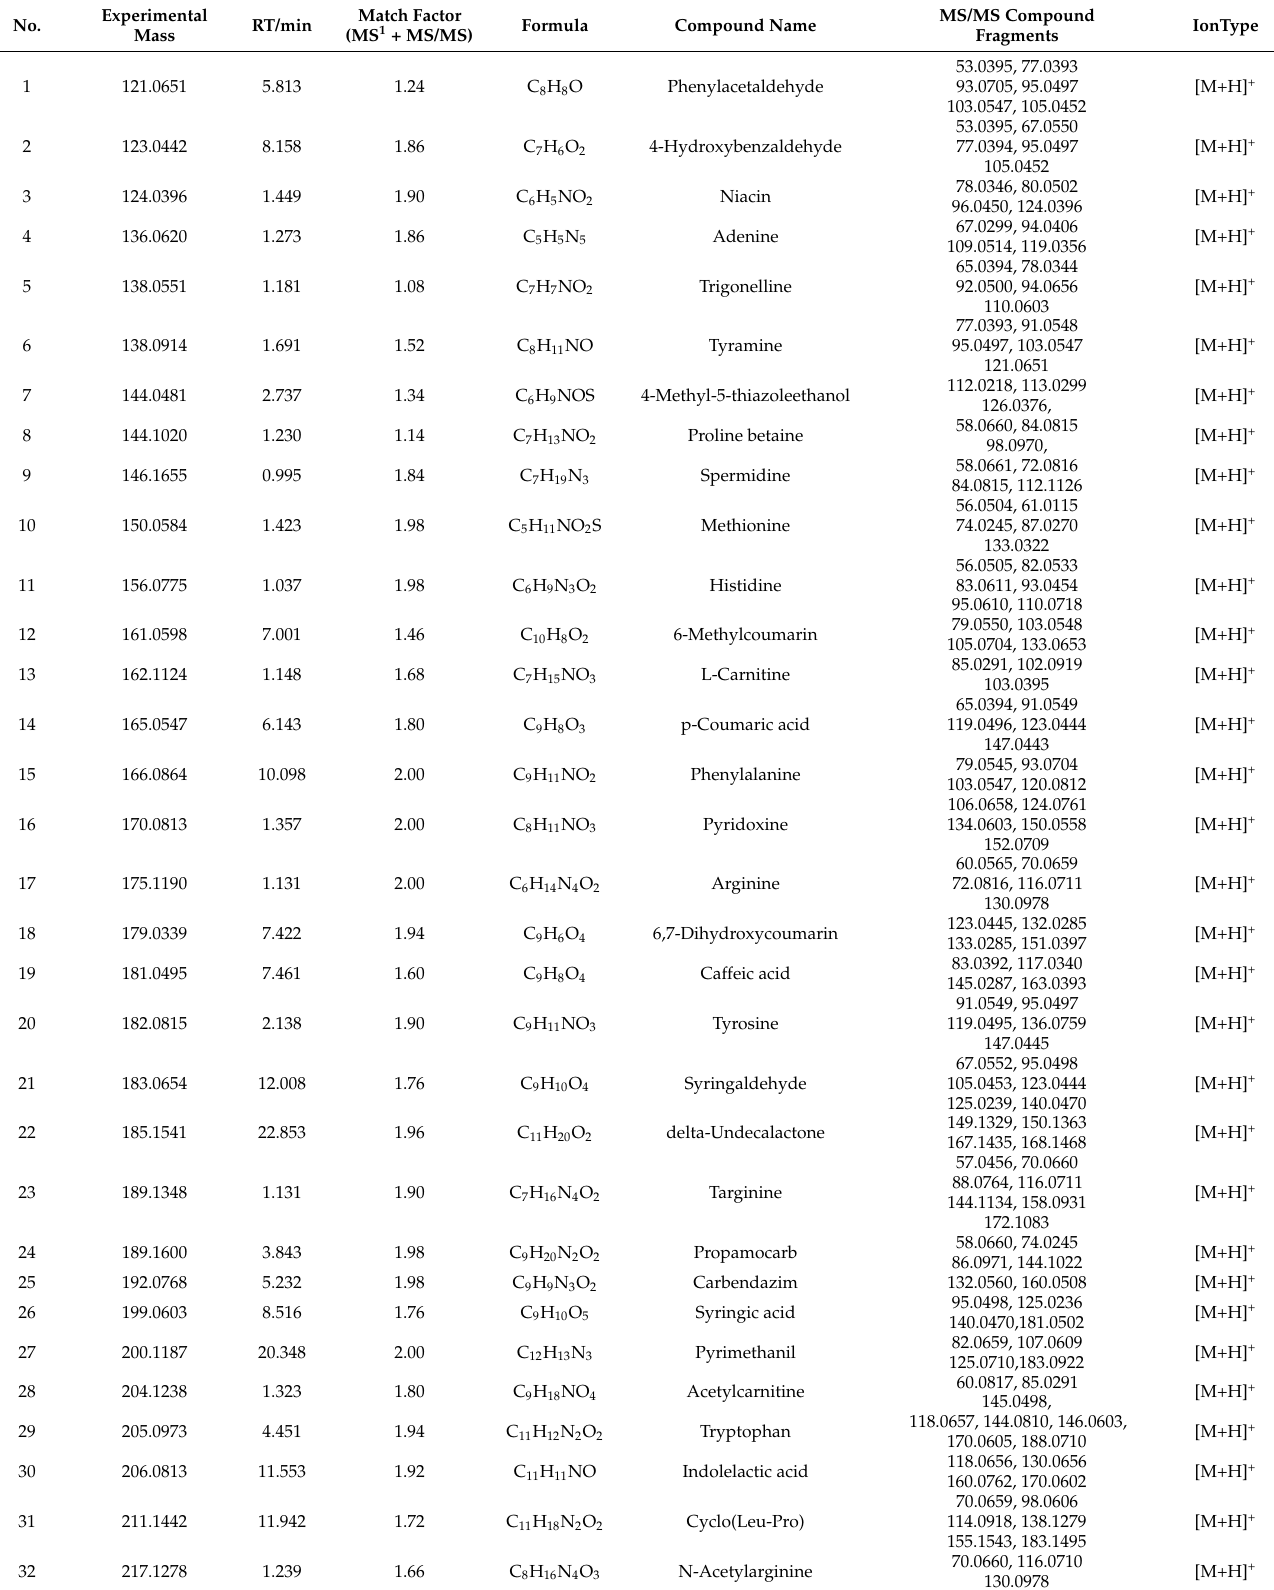
Table 1. The results of the compounds identified with MS 1 and MS/MS constructed with AntDAS in the positive ion